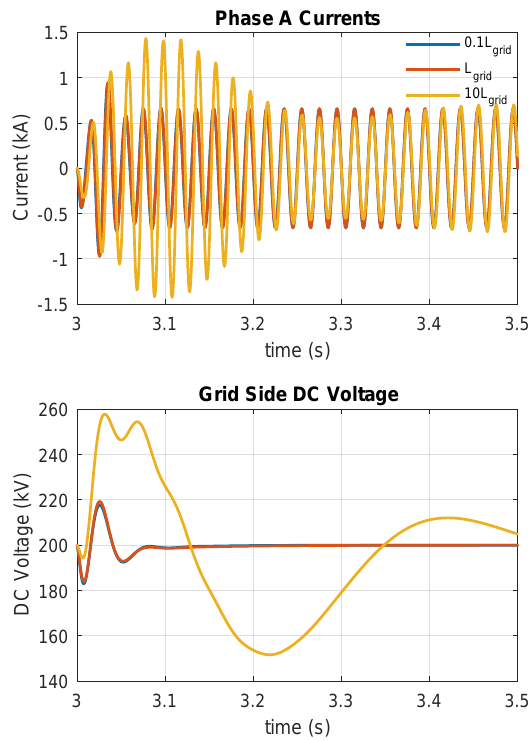
Figure 27. ( Top ) Phase A currents for varying SCRs; ( Bottom ) grid side DC voltages for varying SCRs.